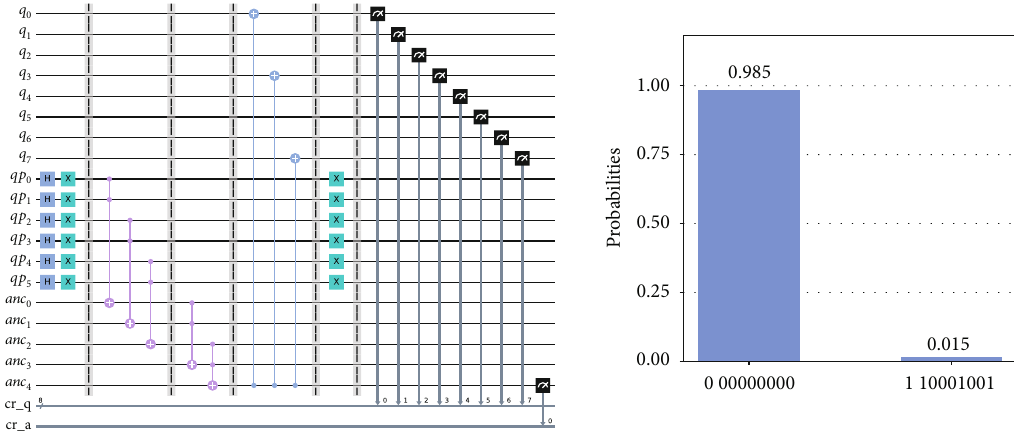
Figure 5: The NEQR representation of gray value 137 (the pixel in the upper-left corner of Alice ’ s image, where the last bit was set to “ 1, ” changing the value from 136 to 137). The binary representation of 137 is 10001001 , where the fi rst bit (to the left) represents the MSB, 2 corresponding to q 7 , and the last one (to the right) — the LSB, corresponding to q 0 ; the classical binary representation of the pixel gray value should be seen in relation to qubits q 7 q 6 q 5 q 4 q 3 q 2 q 1 q 0 . The LSB of the pixel is represented by qubit q 0 , and its state is set to j 1 i (the fi rst bit from the binary representation of 10 , Alice ’ s vote). The auxiliary qubit anc is set to state j 1 i only after the position qubits 2 4 are in the desired state; here, for the fi rst pixel, the desired states are all initially j 0 i , since the target pixel is at coordinates (0, 0), so a round of NOT gates on all position qubits is required. The last three CNOT gates con fi gure the states for the corresponding gray value qubits, q 7 , q 3 , and q 0 , thus ensuring the state matches level 137. The purpose of the fi nal layer of NOT gates is to allow another potential NEQR representation of a new gray value for a di ff erent pixel after this one (they must be set to cancel the NOT gates in the beginning). On the right, in the histogram that illustrates the result of the quantum measurement, we can see that the gray level qubits are only set to their desired states when the anc qubit is in state j 1 i . 4